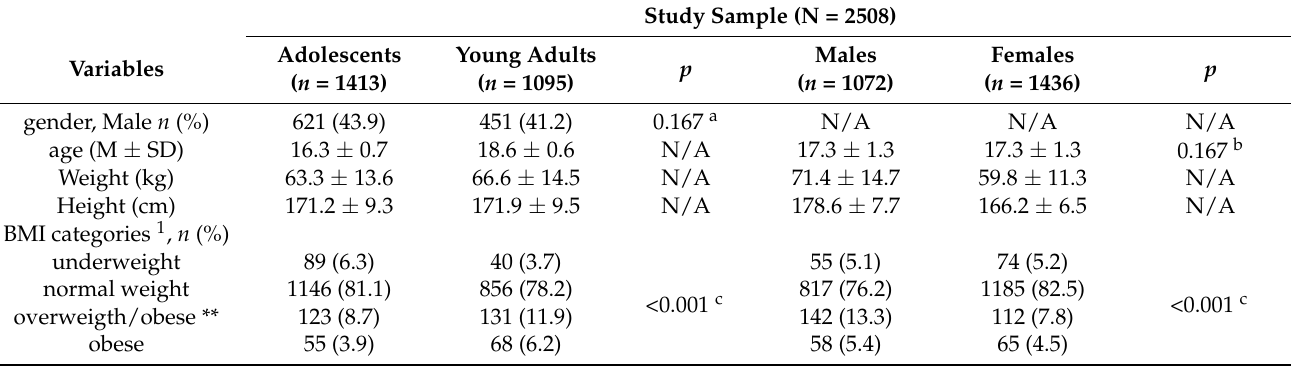
Table 1. Characteristics of the sample. Study Sample (N =